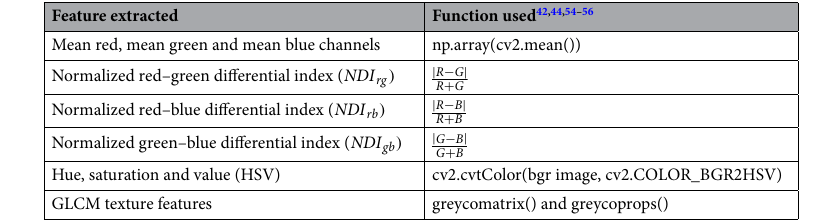
Table 3. Color features extracted from image analysis. The cv2.mean function returns the mean red(R), green(G), blue(B) channel in BGR format. All three mean colors are retrieved by converting function values into using numpy array function(np.array). HSV values were obtained from BGR image by using cv2.cvtColor() function. The six GLCM texture features were obtained using functions greycomatrix() and greycoprops() from skimage